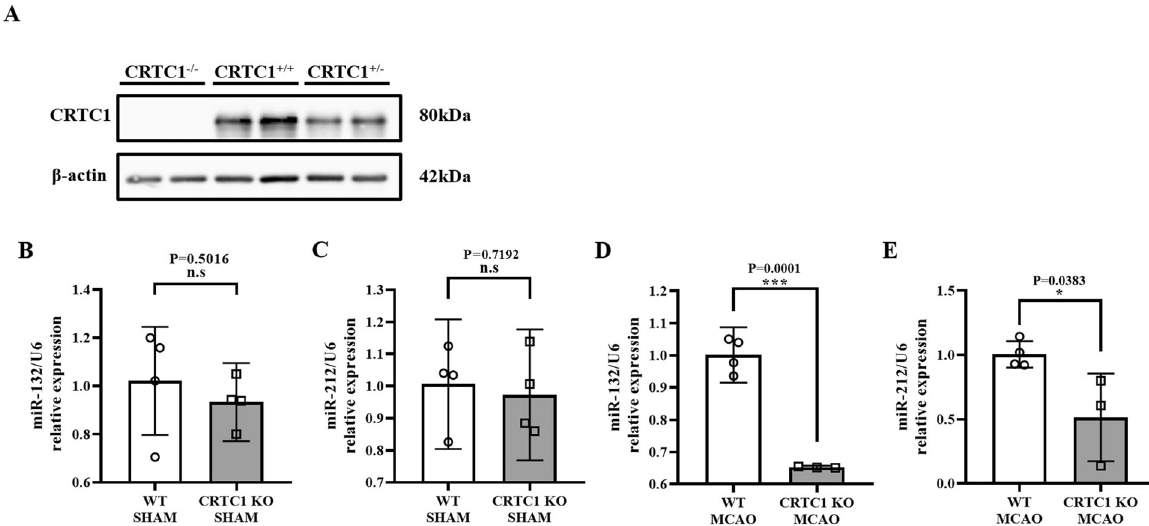
Fig. 1 CRTC1 de fi ciency induces miR-132/212 degradation after MCAO. A Western Blot shows CRTC1 has been completely deleted on C57B/ 6 background mouse. Quantitative polymerase chain reaction (qPCR) results of miR-132 ( B ) and miR-212 ( C ) in CRTC1 KO and WT mice brain under sham group. qPCR results of miR-132 ( D ) and miR-212 ( E ) in penumbra regions of CRTC1 KO and WT mice brain 24 h after MCAO. n = 3 – 4 for each